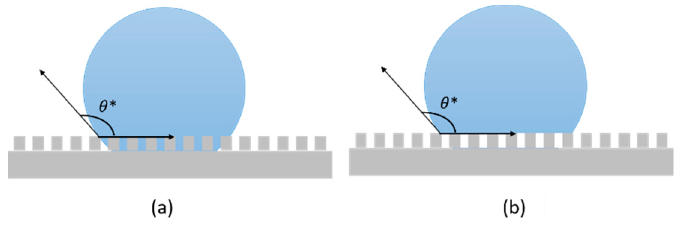
Figure 3. Schematic of droplet in ( a ) Wenzel state and ( b ) Cassie and Baxter state.